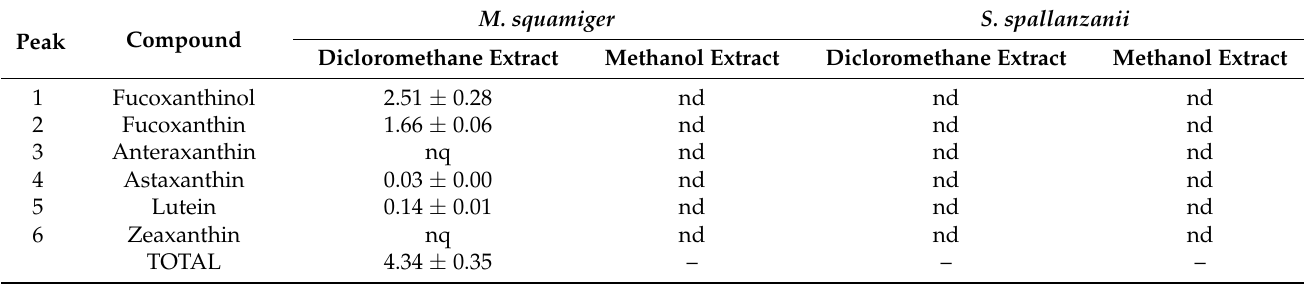
Table 5. Carotenoid content of Sabella spallanzanii and Microcosmus squamiger extracts ( µ g/g dry extract) 1 .